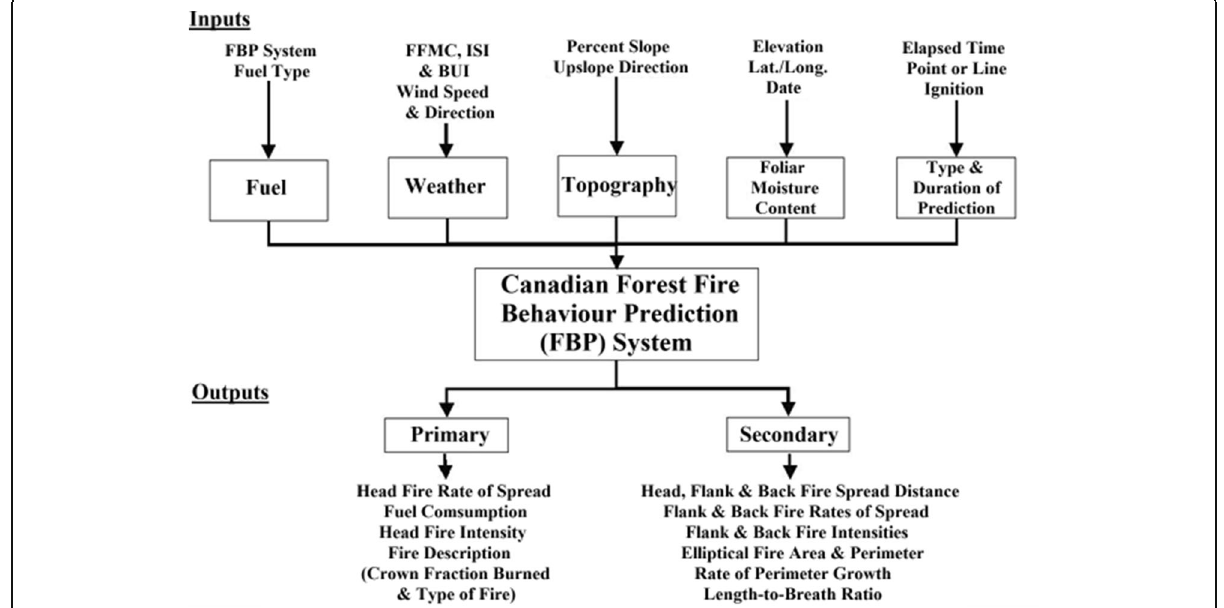
Fig. 3 Structure of the Canadian Forest Fire Behavior Prediction (FBP) System (FCFDG